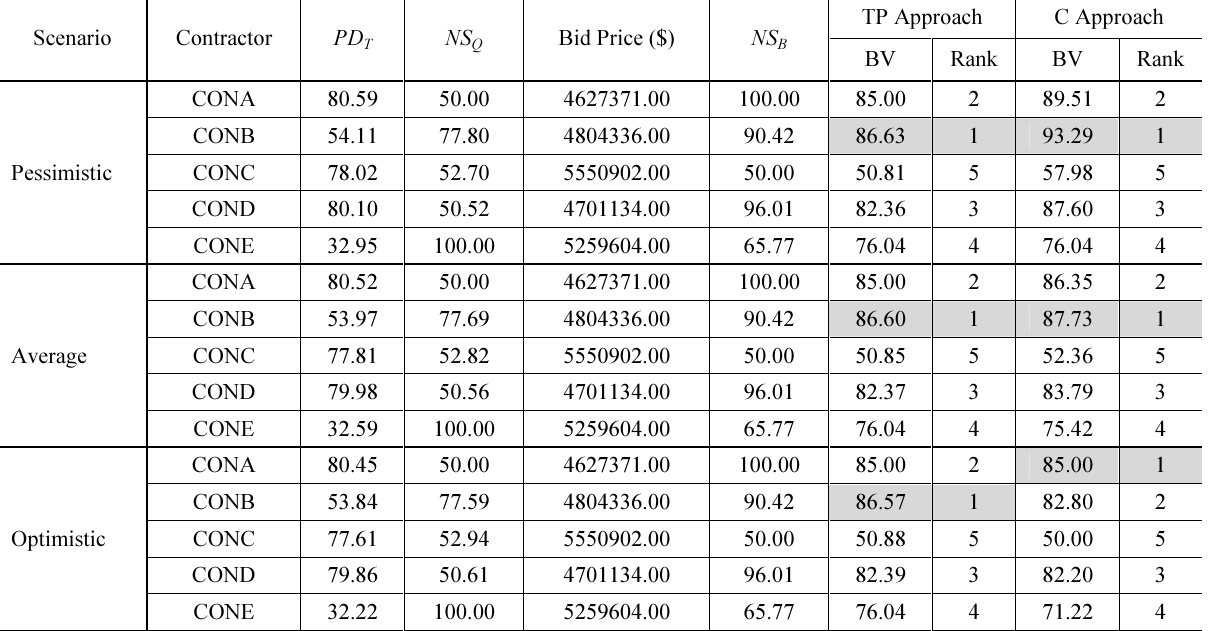
Table 3. Contractor BV and Ranking for Project NH-83-3(107) with SP4 Scenario